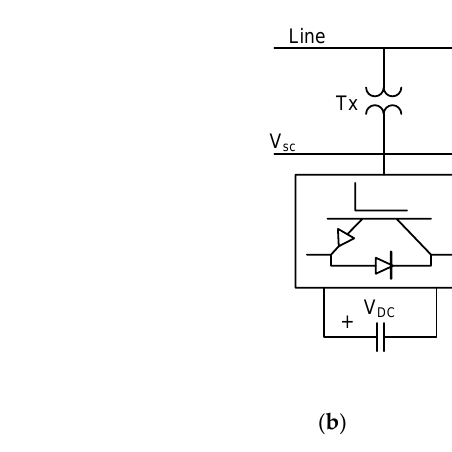
Figure 7. General representation of a ( a ) SVC [103] ( b ) Static Synchronous Compensator [105].